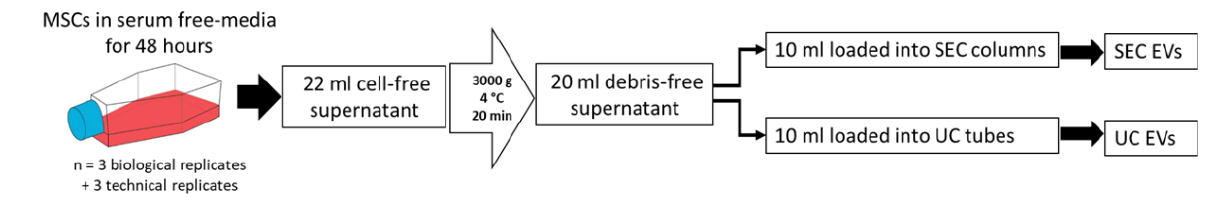
Figure 2. Illustration of the experimental setup: MSCs derived from the bone marrow of 3 equine donors were cultured in serum-free DMEM for 48 h ( n = 3 biological replicates, plus 3 technical replicates per donor). Then, 22 mL of cell-free supernatant was collected from 8 × 10 6 cells per replicate and centrifuged in a 50 mL falcon tube with 3000× g for 20 min at 4 °C. In total, 20 mL of debris-free supernatant was recovered. Half of it was used to isolate EVs by the SEC columns, and the other half was filled into UC tubes.